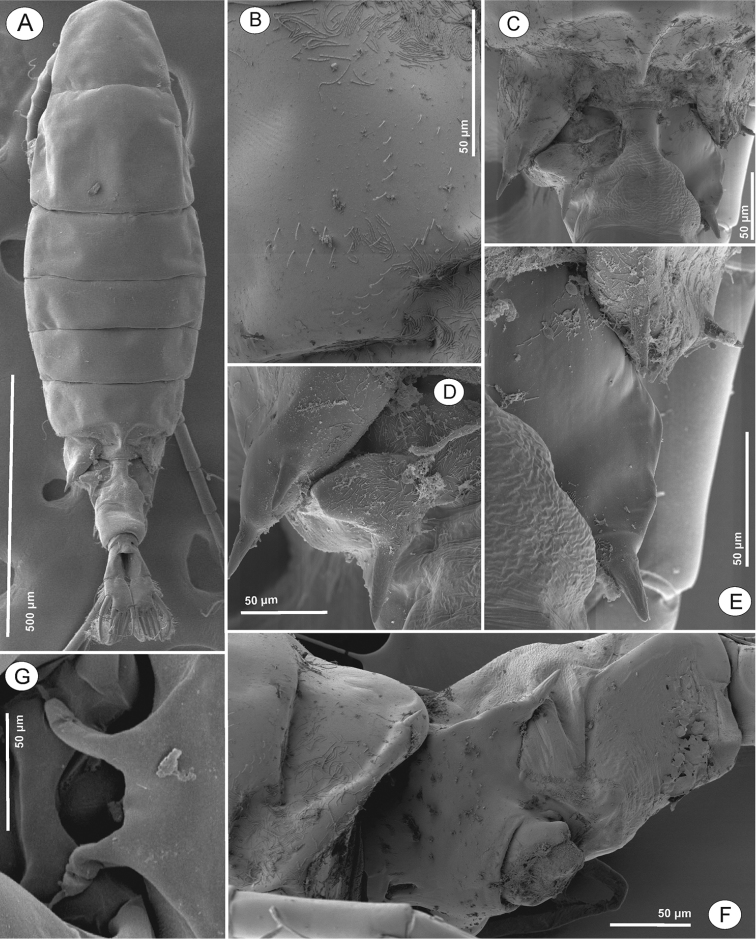
Phyllodiaptomus (P.) roietensis sp. nov., female: A habitus, dorsal view BPdg 4, lateral view CPdg 5 and genital double-somite, dorsal view DPdg 5 and genital double-somite spines, lateral view from left side EPdg 5 and genital double-somite spines, lateral view from right side FPdg 5 and genital double-somite, lateral view G rostral spines.